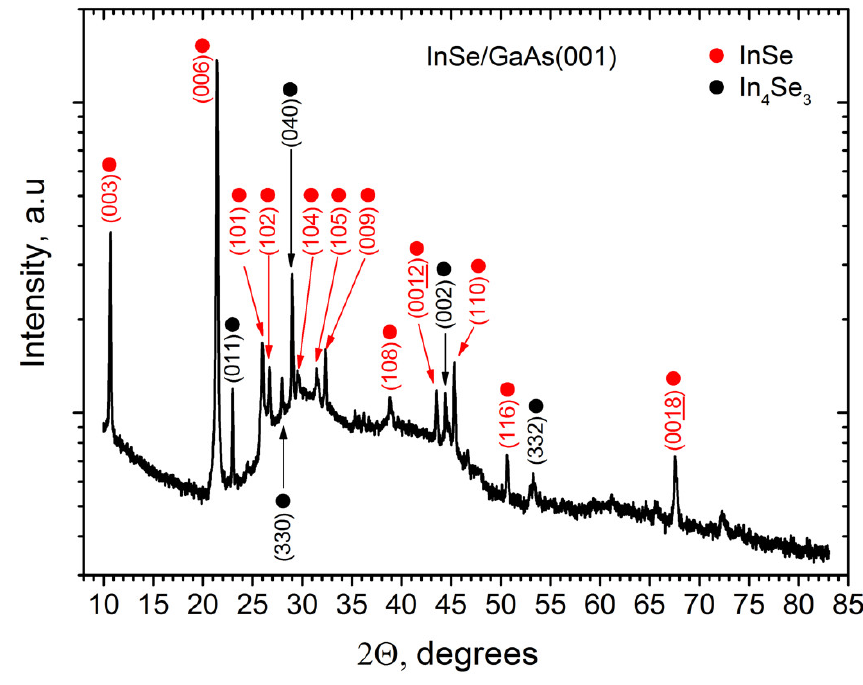
Figure 9. The X-ray powder di ff raction pattern of the InSe / GaAs(001) layer (sample # IS1 ). Reflections corresponding to InSe are indicated by red circles, while reflections that can be attributed to the In 4 Se 3 phase are marked by black circles. The InSe reflections are indexed for the γ -InSe rhombohedral lattice. Raman spectra of the InSe / GaAs(001) layer (sample # IS1 ) measured at 80 and 300 K are shown